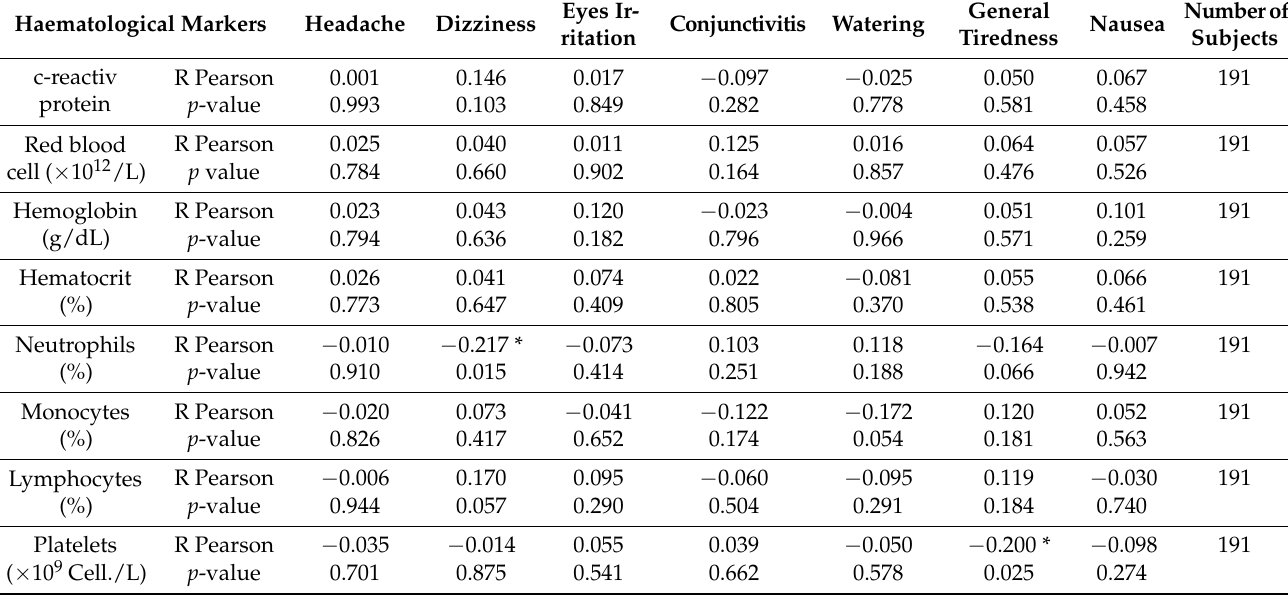
Table 10. Correlation between symptoms related to discomforts and changes of haematological markers. Haematological